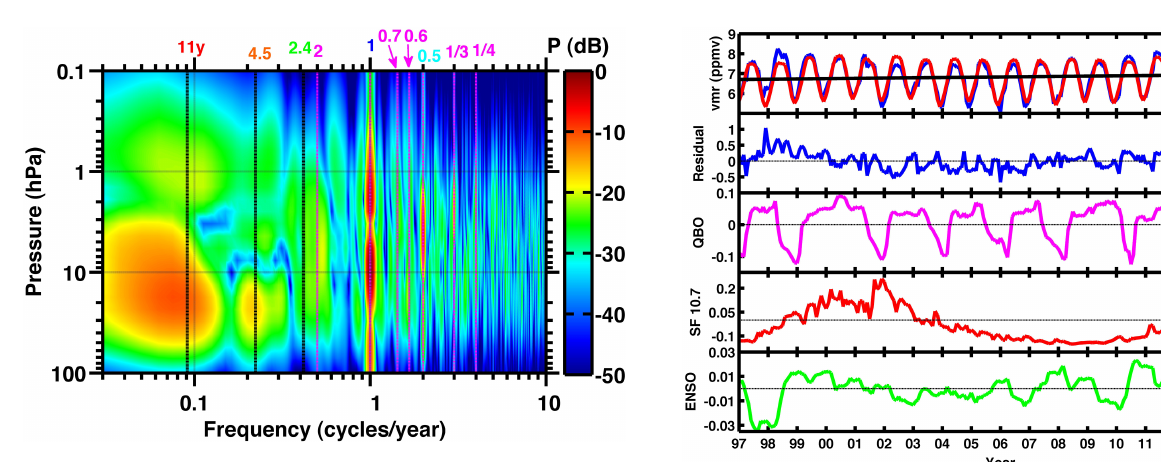
Figure 6. Power spectra of stratospheric ozone time series mea- sured by GROMOS above Bern, Switzerland. The black dotted lines are the frequencies for the annual and semi-annual oscillation, the 11 years due to the solar cycle, the 2.4 years of the QBO and the 4.5 years of ENSO phenomenon. The magenta dotted lines are the frequencies of the overtones (3, 4, 7.2, 8.4 and 24 months).